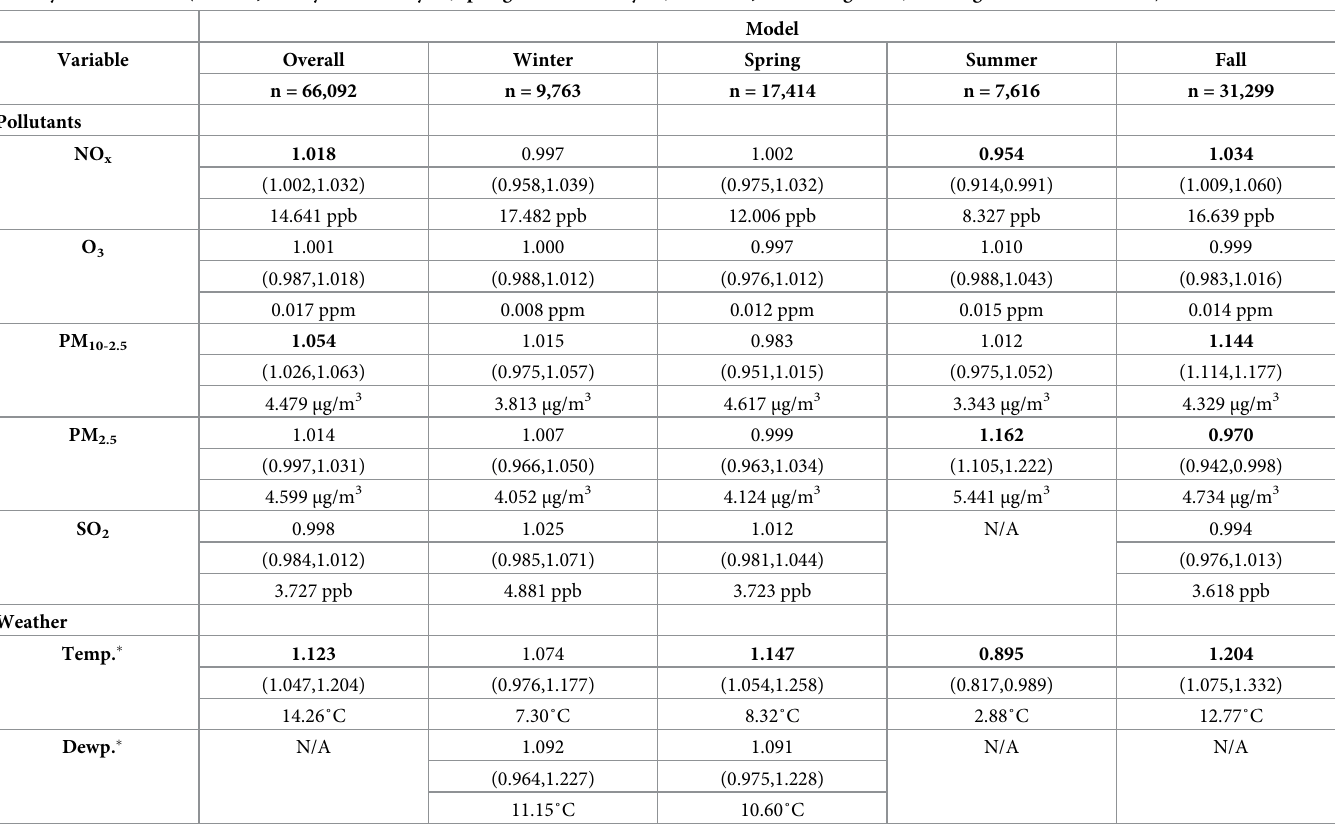
Table 2. Fully adjusted estimated odds ratios for interquartile range (IQR) increases in 3-day moving averages (3DMAs) of air pollutants (OR IQR ), 95% credible intervals, and IQRs (overall and season-specific) for asthma emergency department (ED) visits among children ages 5–19 years in South Carolina (SC) from 2005 to 2014 by asthma season (winter: January 1 –February 28; spring: March 1 –May 31; summer: June 1 –August 19; fall: August 20 –December 31). Model Variable Overall Winter Spring Summer Fall n =